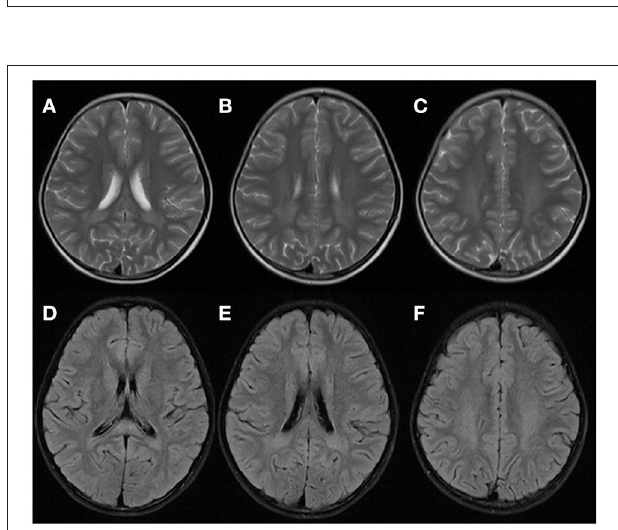
FIGURE 3 | Brain MRI of the patient at the second episode of disease 2 years later. WM appeared hyperintense in T2-weighted axial (A–C) and FLAIR axial (D–F) views, which was similar with that observed during the first attack.